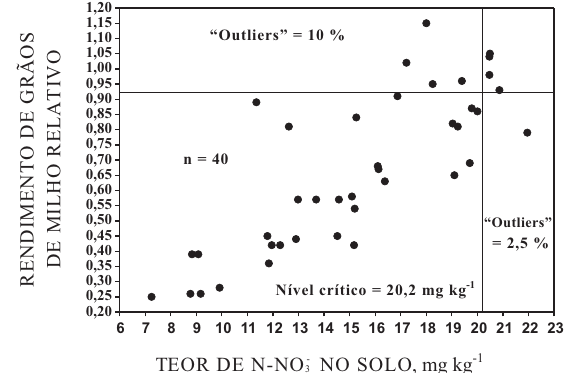
Figura 1. Determinação gráfica do nível crítico de nitrato (N-NO 3- ) no solo, a partir da relação entre o teor de N-NO 3- no solo e o rendimento relativo de grãos do